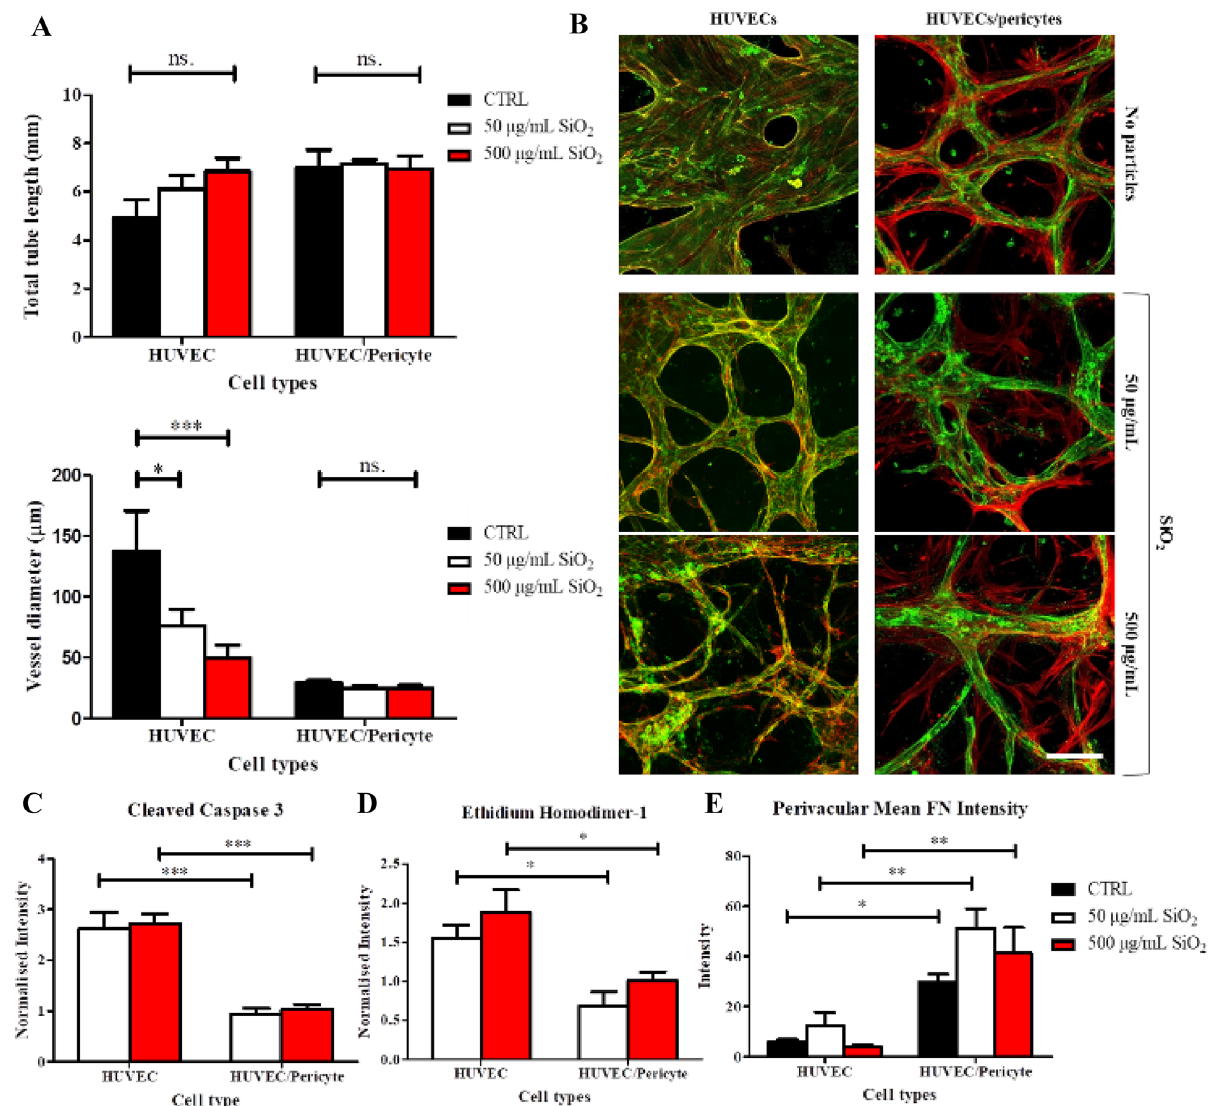
Figure 6. The impact of cationic nanoparticles on vascular network integrity. ( A ) Following 4-day treatment with cationic silica nanoparticles, a significant reduction in vessel diameter is observed in HUVEC monocultures. This is not observed when HUVECs are co-cultured with pericytes. ( B ) Representative images of microvascular networks following treatment with cationic silica nanoparticles, z-projection images were generated using confocal images. Red, F-actin. Green, CD31. Scale bar: 100 μm. ( C – E ) Quantification of relative mean intensity for cleaved caspase 3 (ratio treated/Ctrl) and cytotoxicity via ethidium homodimer-1 (ratio treated/Ctrl) and mean intensity of perivascular fibronectin (FN) deposition. N = 3; n.s., non significant; *, p < 0.05; **, p < 0.01; ***, p <